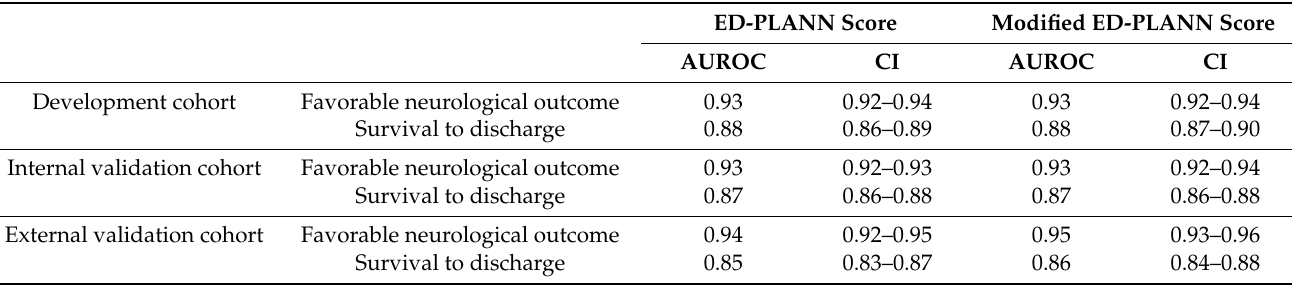
Table 3. Area under the receiver operating characteristic curve in the development and validation cohort